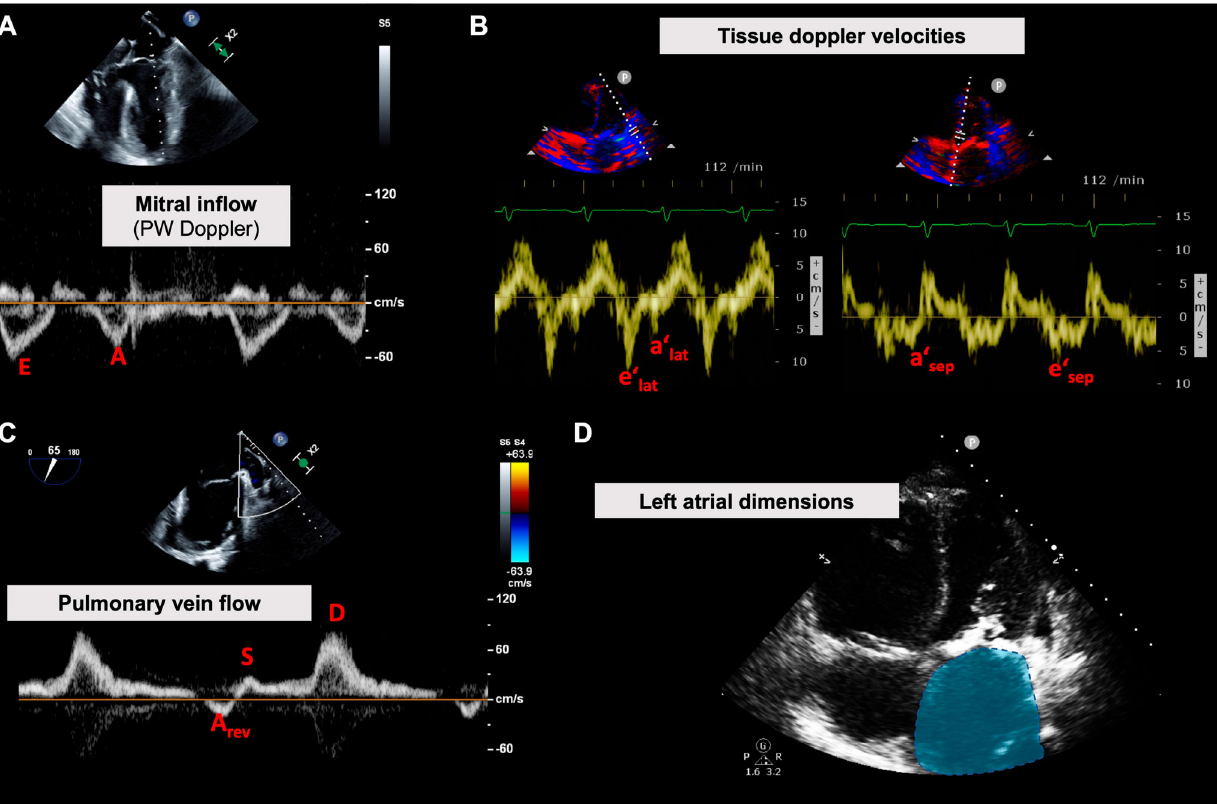
Figure 2. Echocardiographic evaluation of left ventricular diastolic function. ( A ) The blood flow velocities of the mitral valve inflow (E and A wave peak velocities) are measured using PW doppler; for example, in the four-chamber mid-esophageal view. ( B ) Using tissue doppler imaging, the corresponding tissue motion during diastolic inflow yields e‘ and a’ velocities, reflecting relaxation capacity and compliance of the left ventricle. ( C ) The pulmonary vein doppler flow profile can be acquired using both transthoracic and transesophageal echocardiography. While the A rev flow is physiologically reversed, the reversal of the S and D flow can hint at increased left ventricular filling pressures. ( D ) The dimensions of the left atrium are easily acquired, for example here in the transthoracic apical four-chamber view. Enlargement of the left atrium is a sign of advanced diastolic